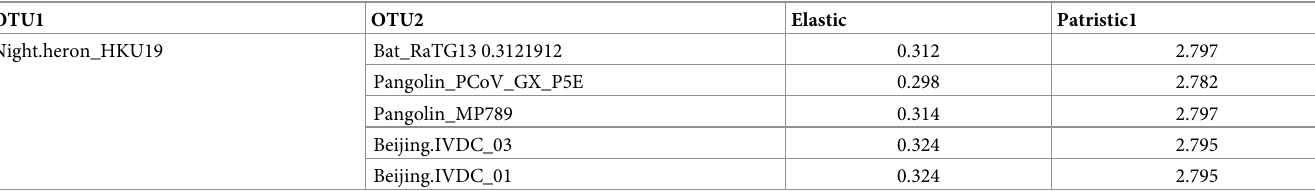
Table 3. Coronavirus strains with a small interstrain distance on the elastic map, but a large patristic1 distance.